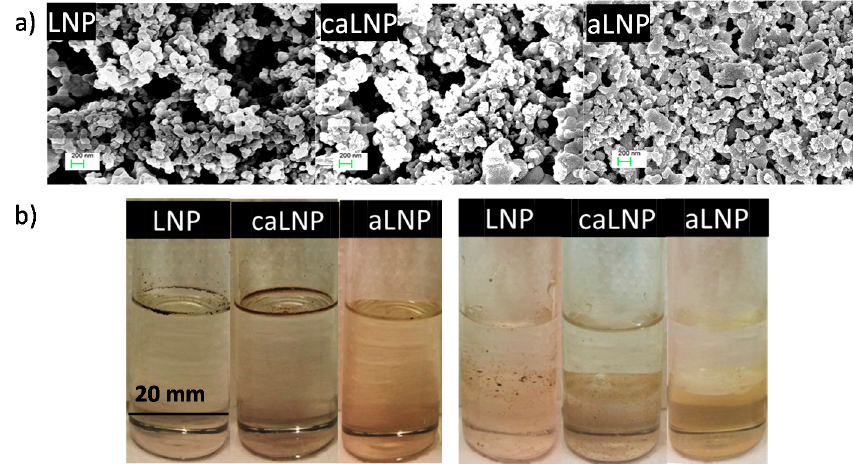
Figure 1. ( a ) FE-SEM micrographs of lignin nanoparticle (LNP), treated with citric acid lig- nin nanoparticle ( caLNP) and acetylated lignin nanoparticle (aLNP) and ( b ) changes in LNP’s ticle (caLNP) and acetylated lignin nanoparticle (aLNP) and ( b ) changes in LNP’s polarity resulting polarity resulting from chemical modification: (left) LNP, caLNP and aLNP (5 mg) in from chemical modification: ( lef t) LNP, caLNP and aLNP (5 mg) in chloroform (10 mL); ( right ) LNP, chloroform (10 mL); (right) LNP, caLNP and aLNP (5 mg) in 50/50% v / v water (upper caLNP and aLNP (5 mg) in 50/50% v / v water (upper phase)/chloroform (lower phase) phase)/chloroform (lower phase) system.